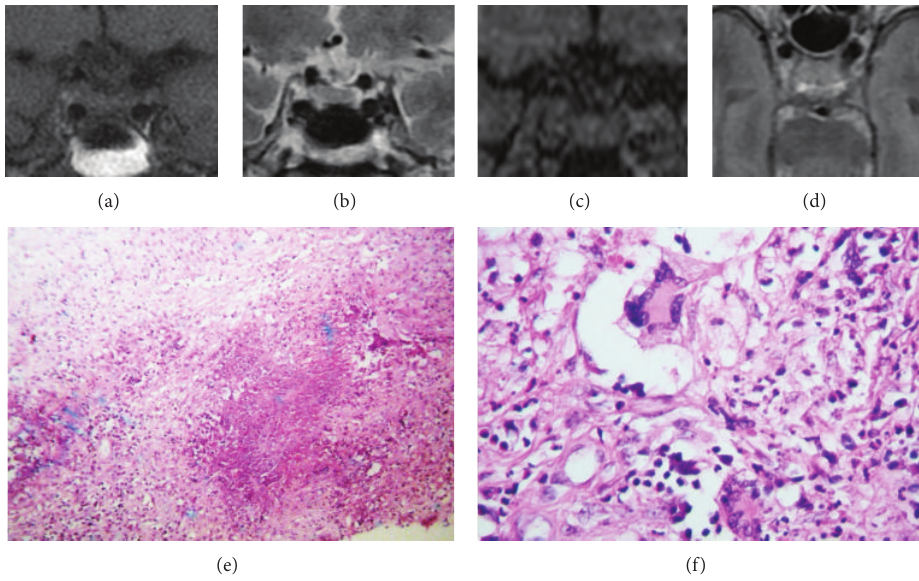
Figure 1: MRI T1-weighted (a), T2-weighted (b), and contrast enhanced T1-weighted (c) of a 67-year-old woman presenting with impaired vision and temporal visual field deficit two months before admission. MRI was done two months after the surgery with pterional approach and showed persistence of intrasellar lesion with stalk involvement. Photomicrograph × 40 H & E (e) and photomicrograph × 400 H & E (f) showcentralcaseousnecrosiswithlymphocyticinflammatoryinfiltrate,extensivefibrosis,Langhansmultinucleatedgiantcellwithepithelioid cells, and lymphocytes, with few